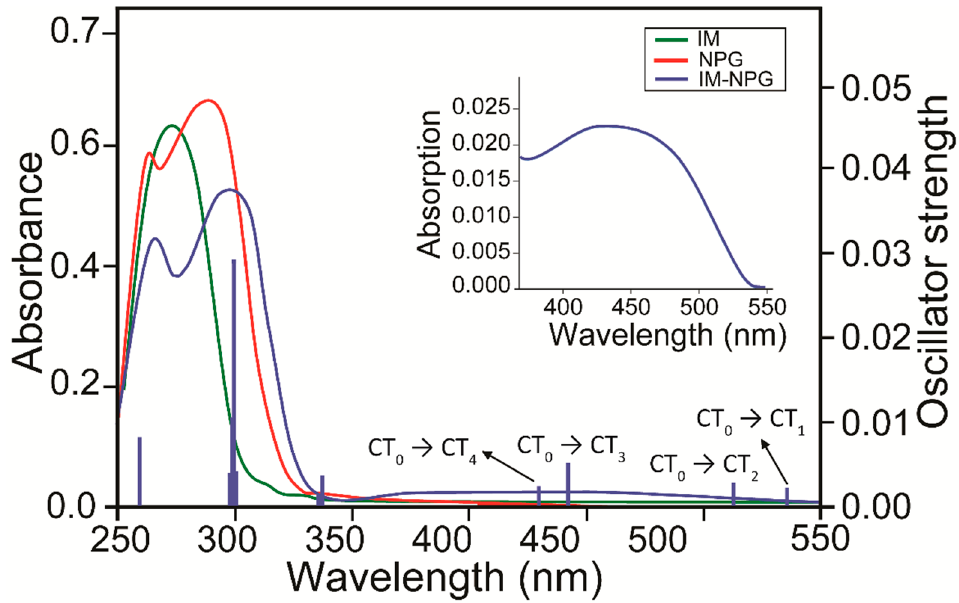
Figure 1. Absorption spectra (curved line, left axis) of IM, NPG, and IM + –NPG − –HYD in EtOH (1 × 10 − 4 M) and oscillator strengths (vertical line, right axis) obtained from TD-DFT calculations at the cam-B3LYP / cc-pVTZ level of theory. The expanded view of experimentally observed broad CT- band (350–550 nm) in IM + –NPG − –HYD is depicted in the right upper corner.